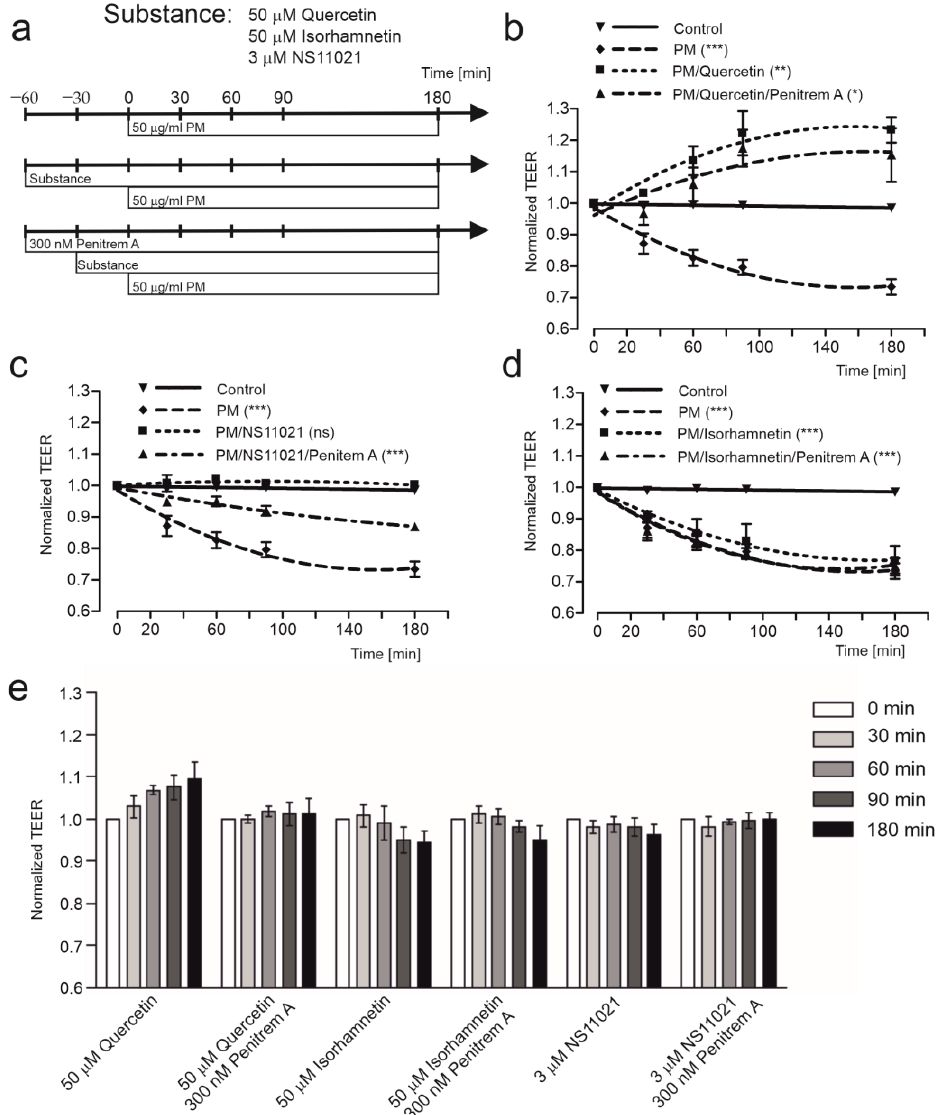
Figure 1. Transepithelial electrical resistance changes of 16HBE14o-cell monolayers. ( a ) Schematic diagram of the experimental protocol. ( b ) TEER change following exposure to Ringer solution alone (control), 50 µg/mL PM with/without 50 µM quercetin, and 300 nM penitrem A. ( c ) TEER change following exposure to Ringer solution alone (control), 50 µg/mL PM with/without 3 nM NS11021, and 300 nM penitrem A. ( d ) TEER change following exposure to Ringer solution alone (control), 50 µg/mL PM with/without 50 µM isorhamnetin, and 300 nM penitrem A. ( e ) TEER change following exposure to Ringer solution supplemented with 50 µM Quercetin, 50 µM Quercetin, and 300 nM penitrem A, 50 µM Isorhamnetin, 50 µM Isorhamnetin, and 300 nM penitrem A, and 3 nM NS11021, 3 nM NS11021, and 300 nM penitrem A. Data were presented as the mean ± SD of experiments conducted independently ( n = 4). Statistical significance of measurements compared to controls was determined at p < 0.05 (*), p < 0.01 (**), and p < 0.001 (***) by one-way ANOVA.